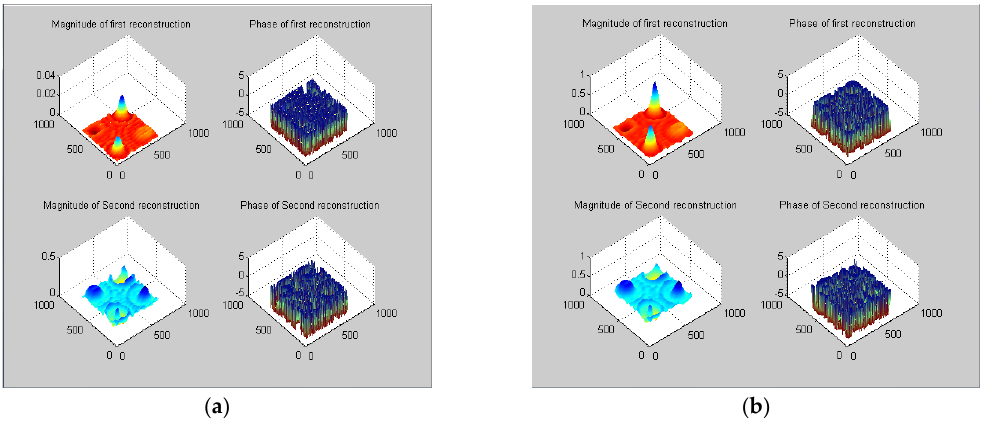
Figure 16. 3D demonstration of the phase and magnitude of the 2D data, ( a ) a reconstructed image based on a wavelet transform, and ( b ) a reconstructed image based on a Gaussian transform.